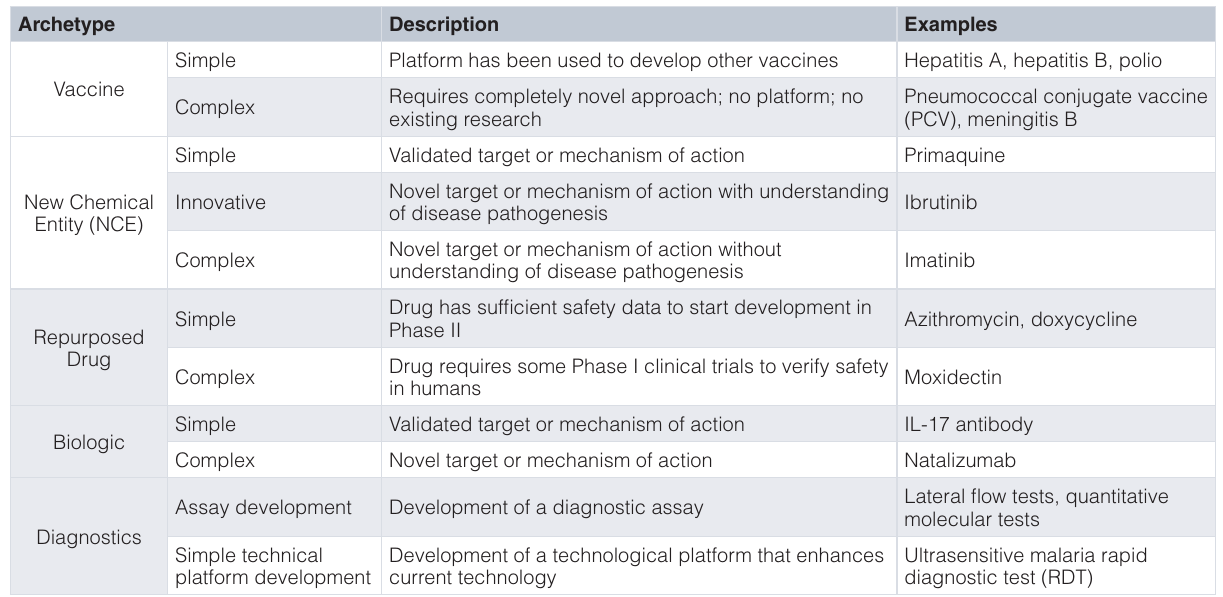
Table 1. Descriptions of archetypes from the P2I v.1 model.